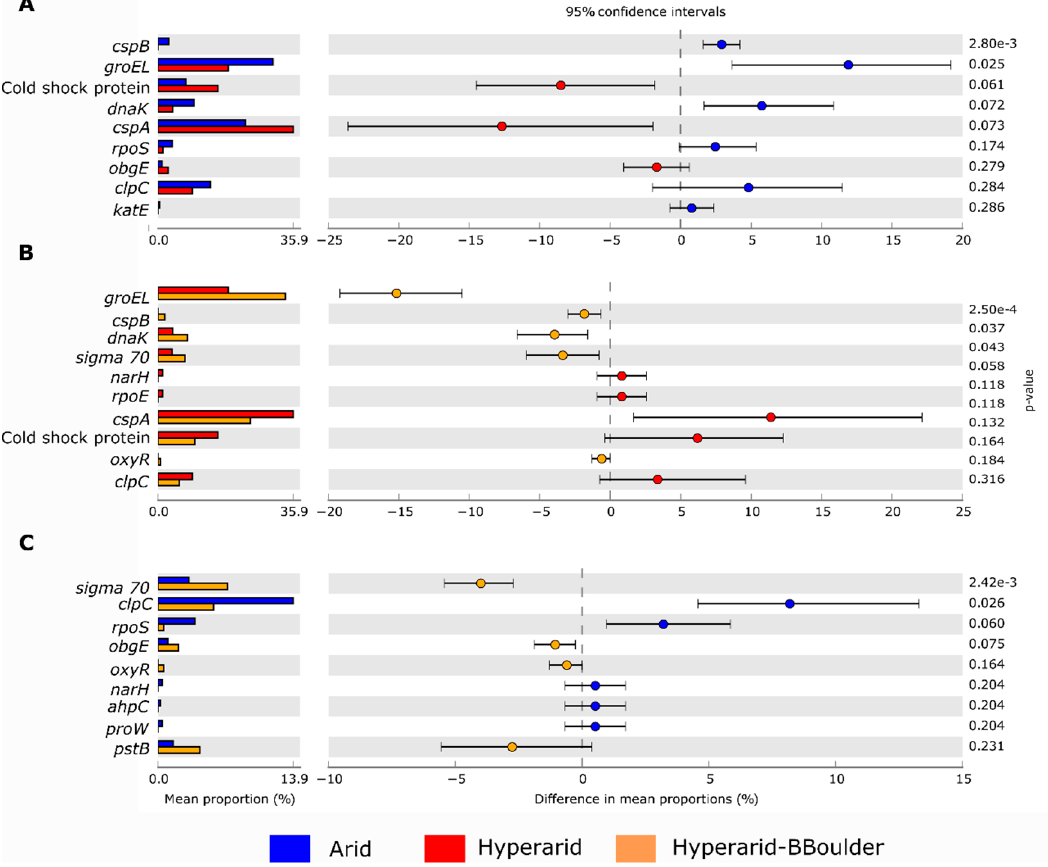
Figure 7. Comparison of bacterial genes coding for stress response in the soil microbiome of the Atacama Desert between ( A ) Arid and Hyperarid sites, ( B ), Hyperarid and Hyperarid-BBoulder sites and ( C ) Arid and Hyperarid-BBoulder sites. Relative abundance was compared using two-side White’s non-parametric t-test. n = 4, 5 and 3 at the Arid, Hyperarid and Hyperarid-BBoulder sites, respectively.